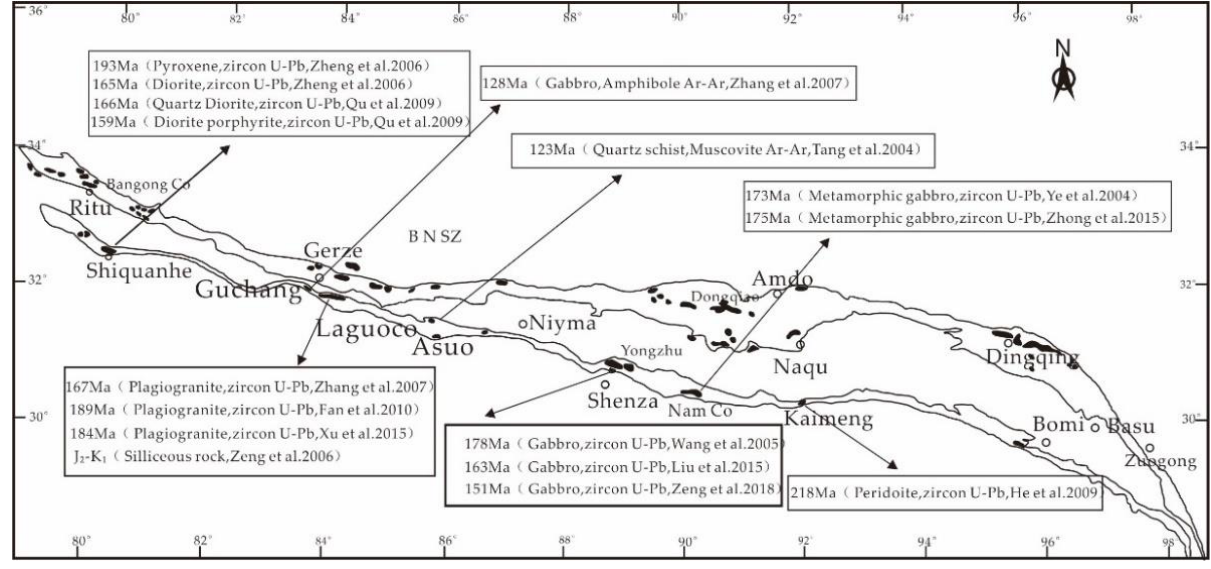
Figure 10. The age distribution of the main ophiolite, the base map modified after [51].